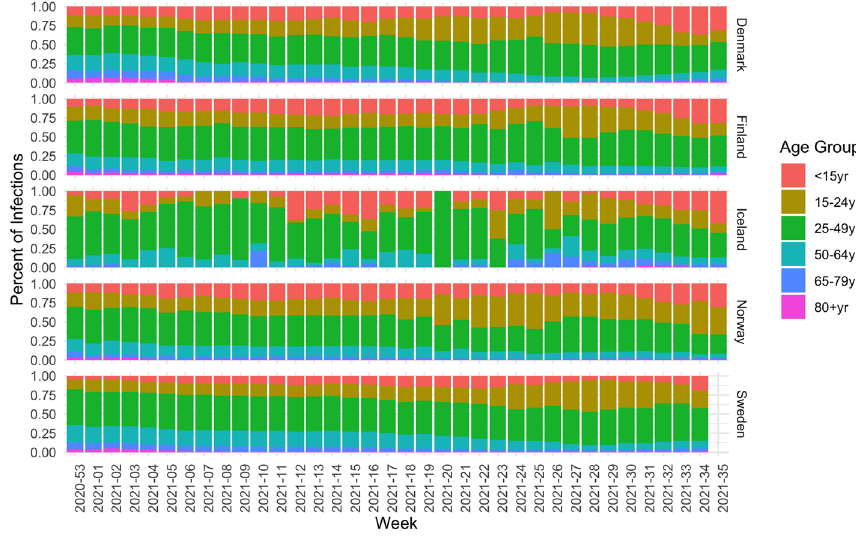
Figure 2. Percentage of each age group of all new infections per week in the five countries.